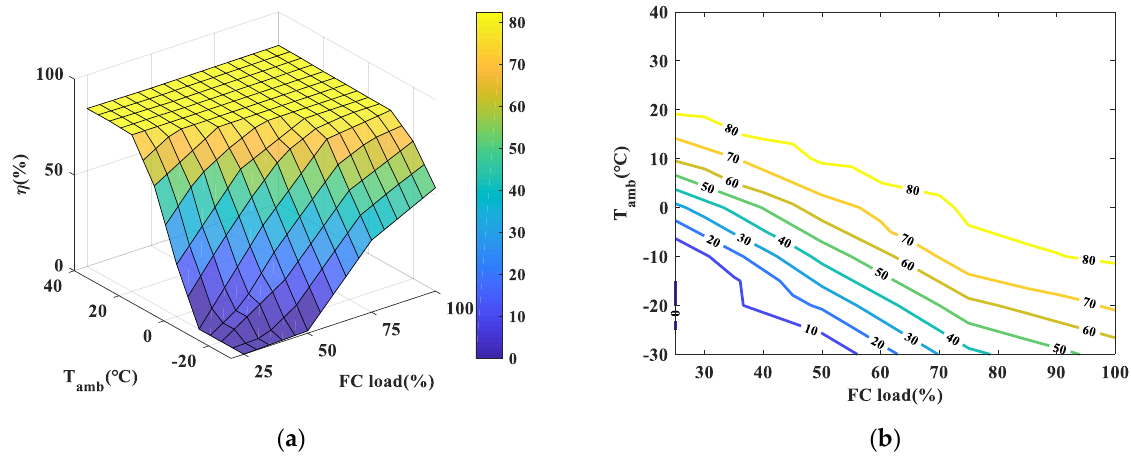
Figure 10. LH 2 cold energy utilization ratio results: ( a ) Cold energy utilization ratio as a function of ambient temperature and FC load; ( b ) Cold energy utilization system contour map.